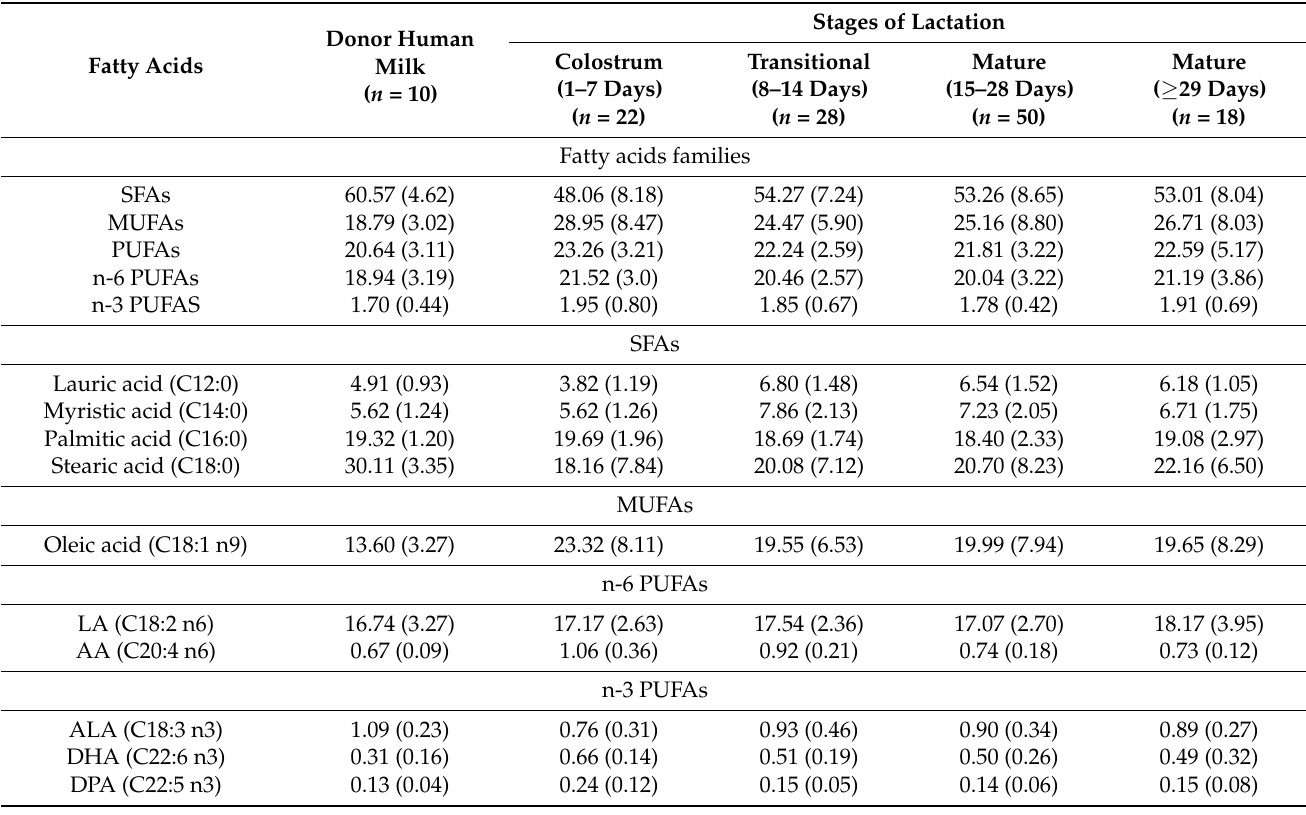
Table 2. Lipid profile (% molar of total fatty acids) in donor human milk and mothers’ own milk samples from different stages of